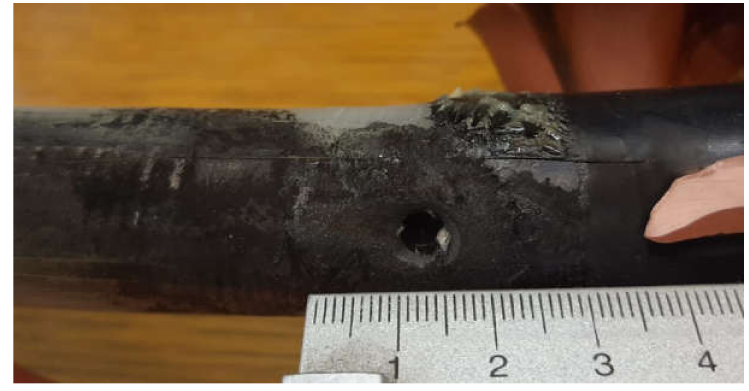
Figure 17. Breakdown location in the cable